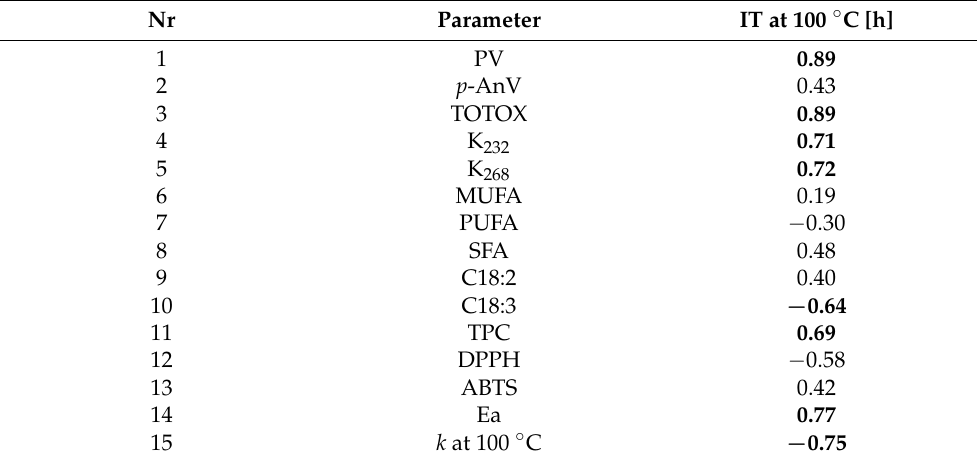
− 0.75 The values in bold show the correlations statistically significant at the significance level p = 0.05. PV—peroxide value; p -AnV— p -anisidine value; Totox—total oxidation indictor; K232 and K268—specific extinction coeffi- cient at wavelength λ = 232 and 268. MUFA—monounsaturated fatty acids; PUFA—polyunsaturated fatty acids; SFA—saturated fatty acids; TPC—total phenolic content; DPPH—antioxidants activity measured